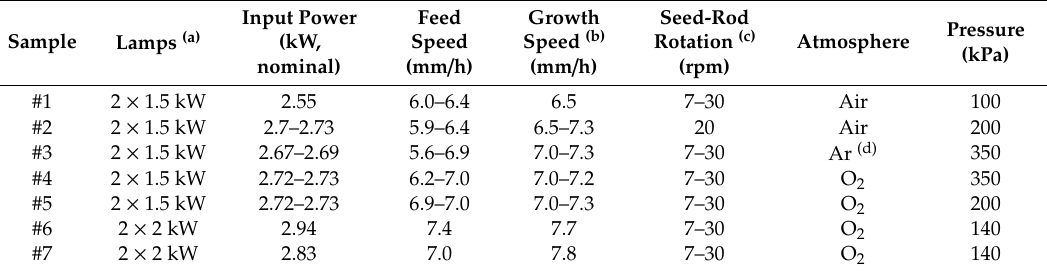
Table 1. Condition of Y 2 Ti 2 O 7 crystal